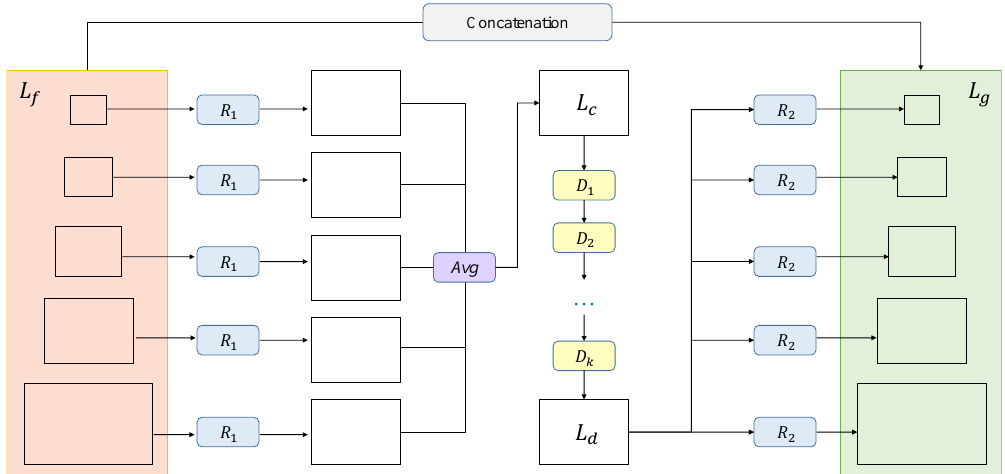
Figure 2. A detailed structure of the Global Density Model. In GDM, the FPN features L f are fused to a refined feature L c via a resizing operation R 1 shown with blue color and an average function Avg in the purple rectangle. The global feature L d is obtained from dilated convolutional networks D and eventually scattered to multi-levels L g by a residual